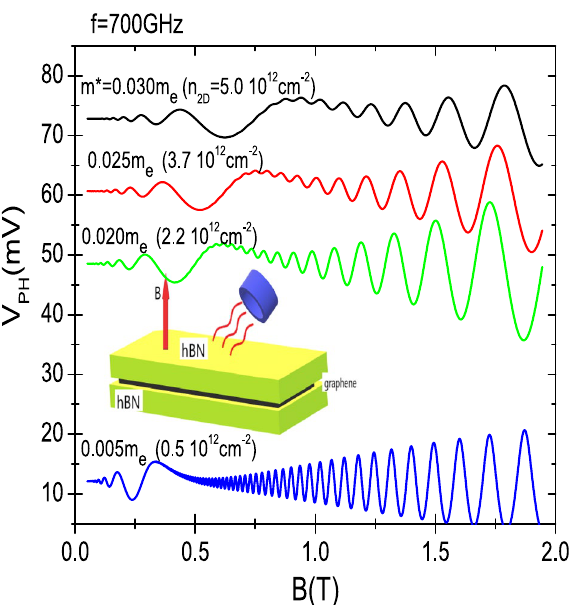
Figure 2. Calculated photovoltage, V ph , under radiation vs magnetic field for h-BN encapsulated monolayer 1 K . Every effective mass (charge density) graphene. The radiation frequency is 700 GHz and temperature T = corresponds to a different bias between the hBN layers (top and bottom). We observe that the oscillations amplitude does not significantly change with the effective mass (gate voltage). The inset shows a schematic diagram of the h-BN sandwiched monolayer graphene under a constant magnetic field and